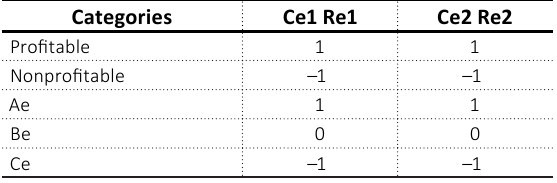
Table 6. Coordinates for the graph: